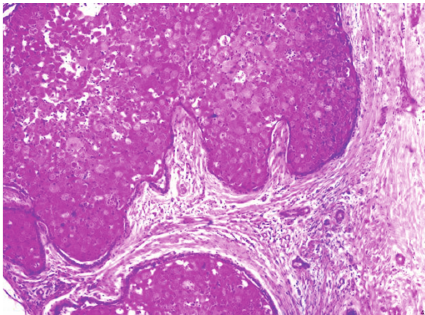
Figure 4: Large odontogenic islands showing peripheral amelo- blast-like cells and central stellate reticulum-like cells with extensive granular cell transformation surrounded by fibrous stroma (H and E 20x).